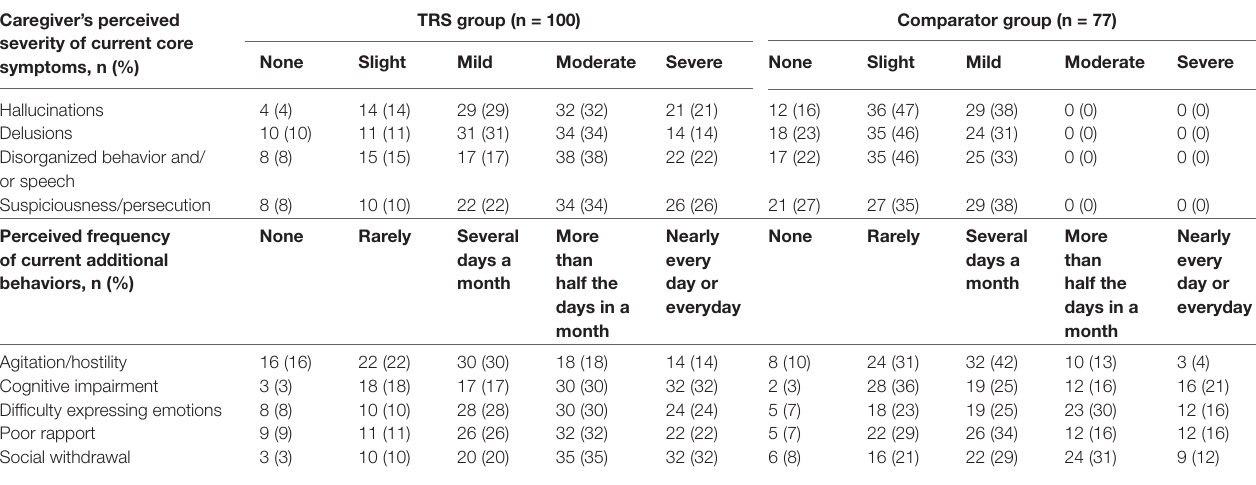
TABLE 2 | Presence of persistent positive